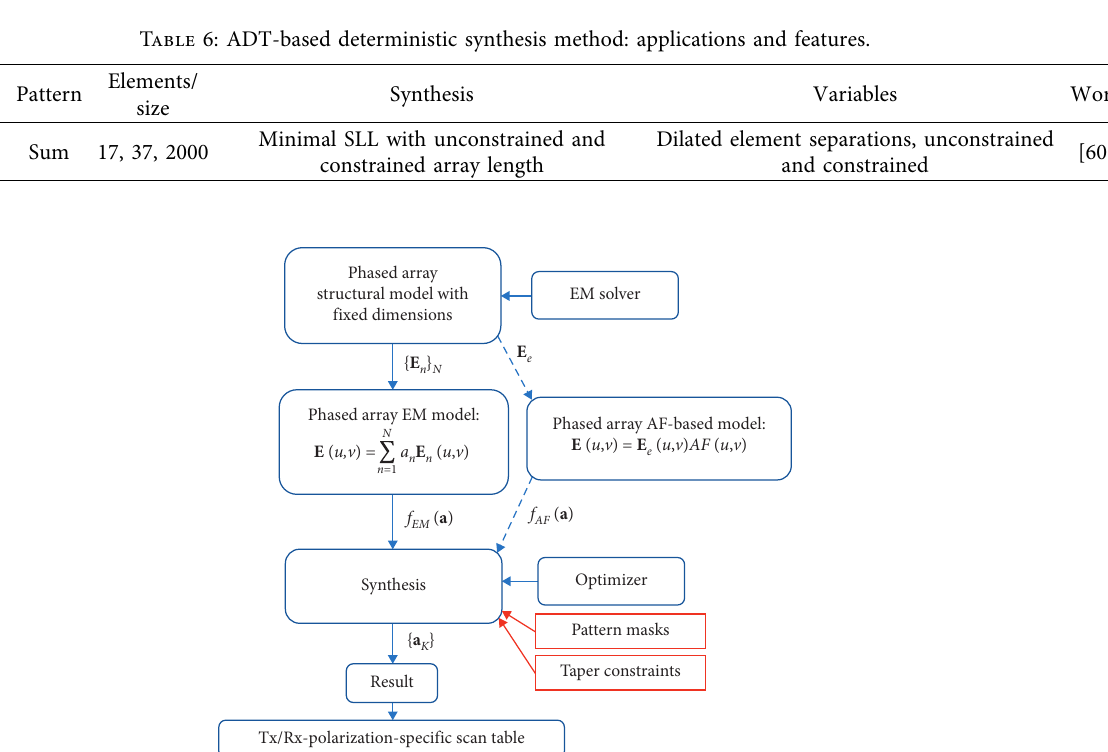
Figure 18: Simplifieddiagramofaphasedantenna arraypatternsynthesiswithnonidenticalfar-fieldresponsesoftheembeddedradiating